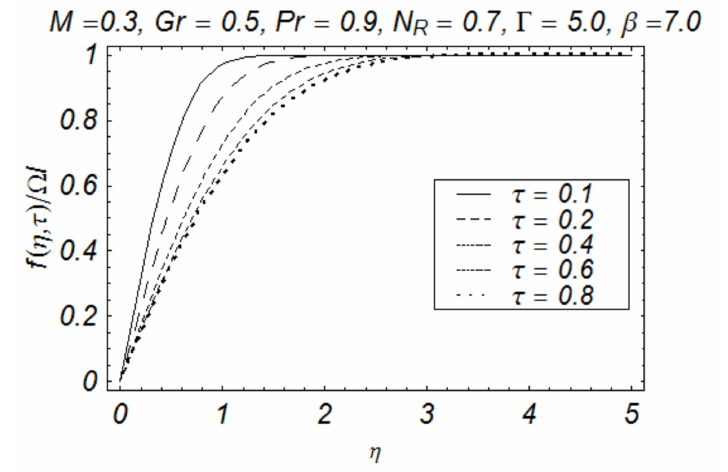
Figure 2. Indication of τ on primal